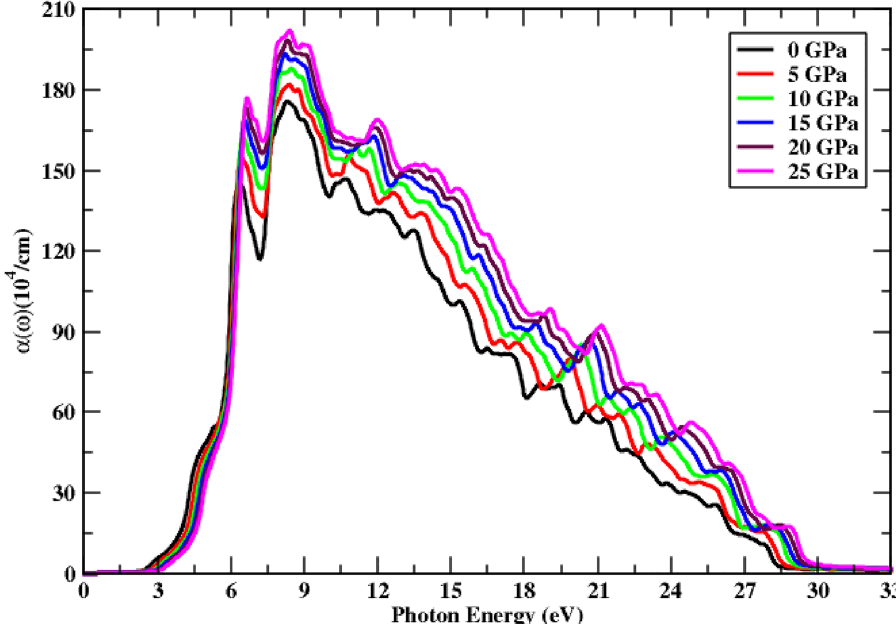
Figure 5. Change in absorption under the pressure’s